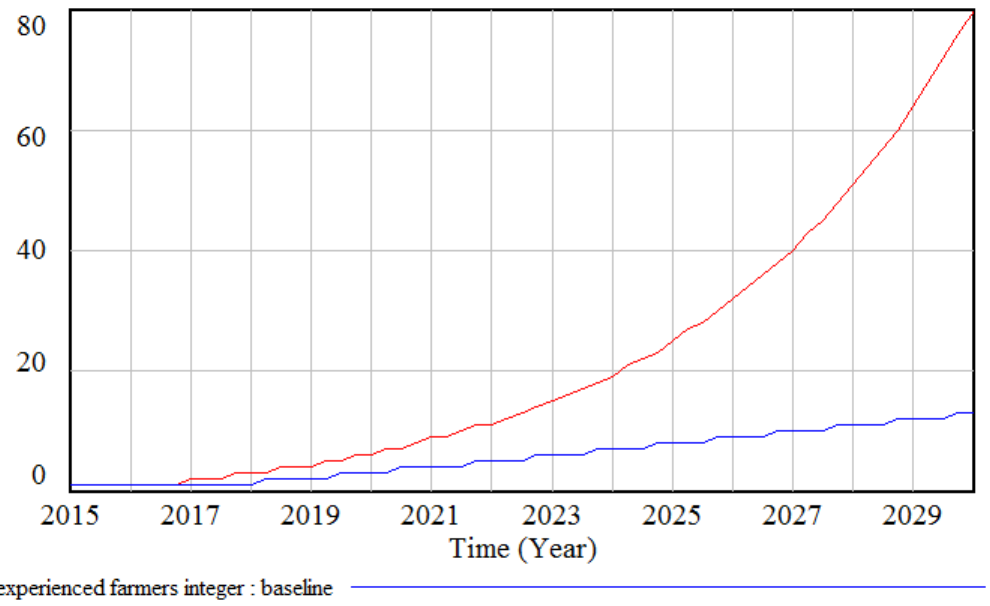
Model Output: Number of Experienced